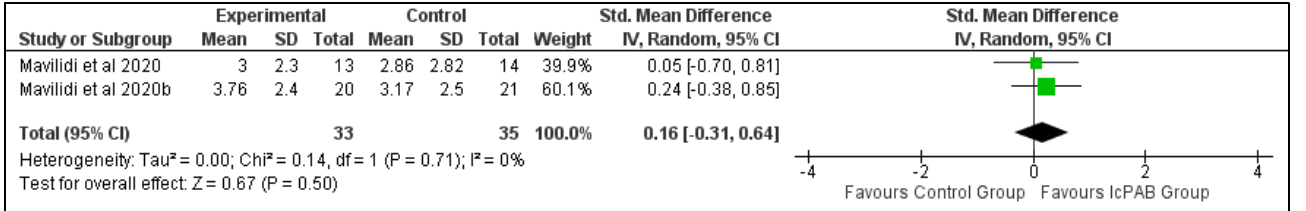
Figure 5. Effects of IcPAB on Test Anxiety (health-related